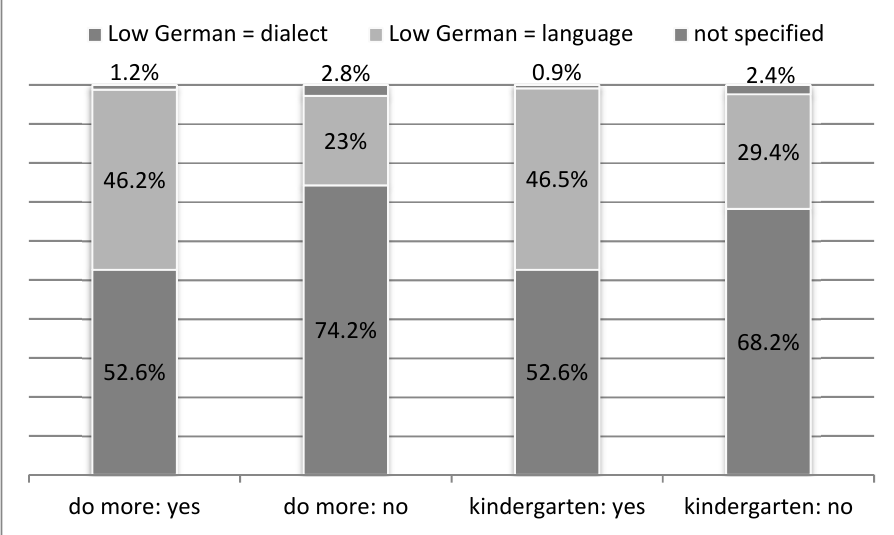
Figure 5. The assessment of Low German’s status by other attitudes on Low German (NGS2016).